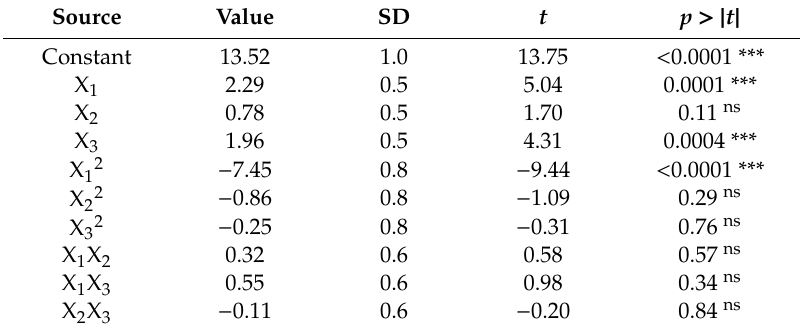
Table 3. Values, standard deviations and statistical analysis of the regression coe ffi cients for the SILM extraction yield (Y SILM ) from mature fruits of S. marianum as a function of the 3 di ff erent variables (X 1 : aqEtOH concentration, X 2 : US frequency and X 3 : extraction